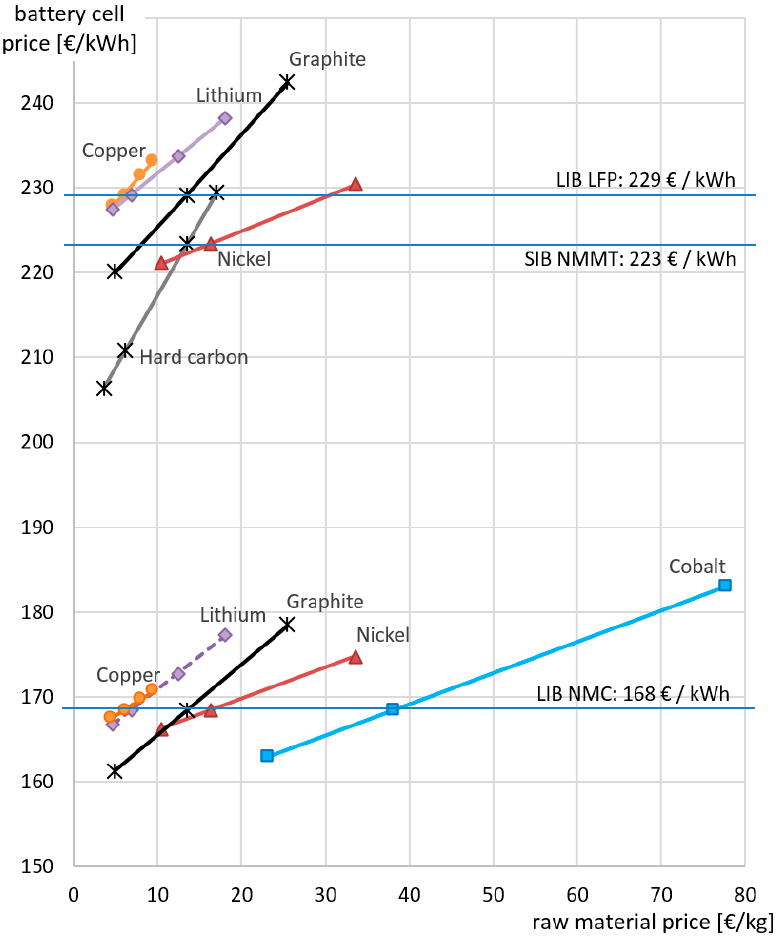
Figure 5. Sensitivity of the final battery price on variations in raw material prices (10-year minimum, average, and maximum; for lithium additionally 10y max + 50%).